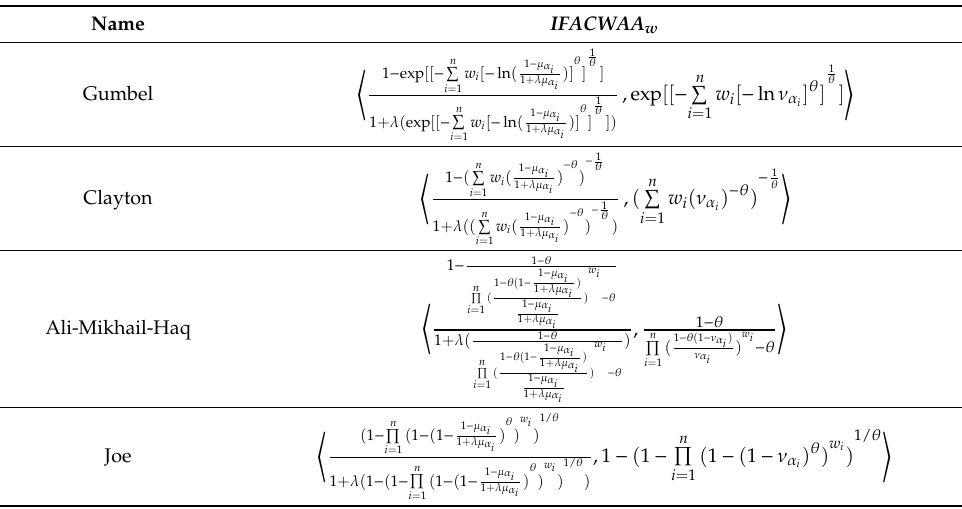
Some Sugeno-Based Intuitionistic Fuzzy Archimedean Copula Weighted Arithmetic Aggregation Operators.